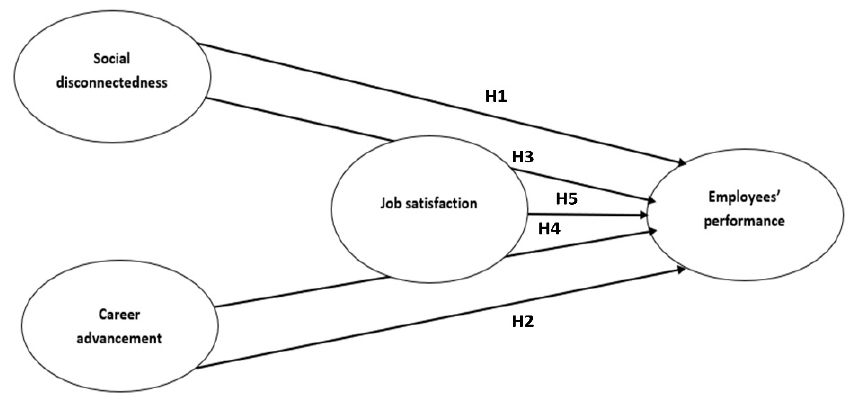
Figure 1. Research framework.